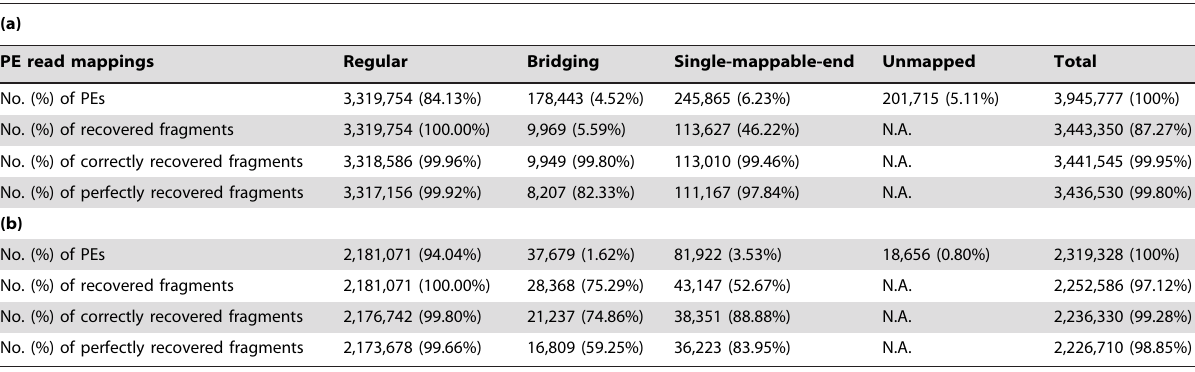
Table 6. Statistics of DNA fragments recovered from the real PEs of bacteria.